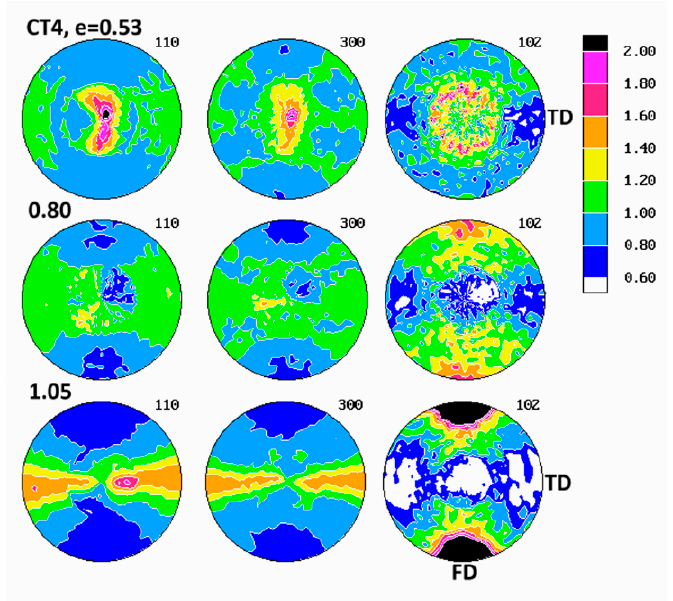
Figure 14. Selected pole figures of the (110) (300) and (102) crystallographic planes (Form I) determined for samples of C4 copolymer drawn in uniaxial tension to the true strain indicated.